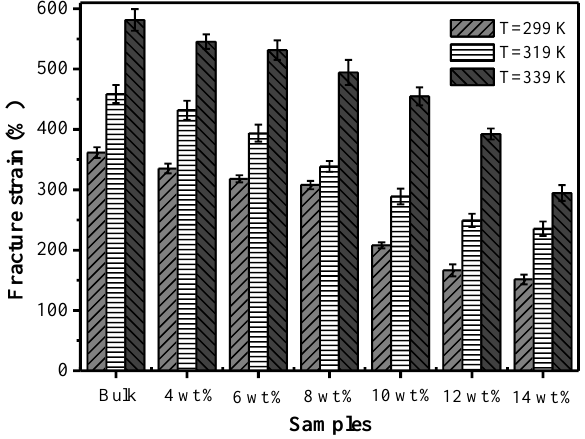
Figure 10. The effects of different chopped carbon fiber contents on fracture strain at three test temperatures of 299 K, 319 K and 339 K.